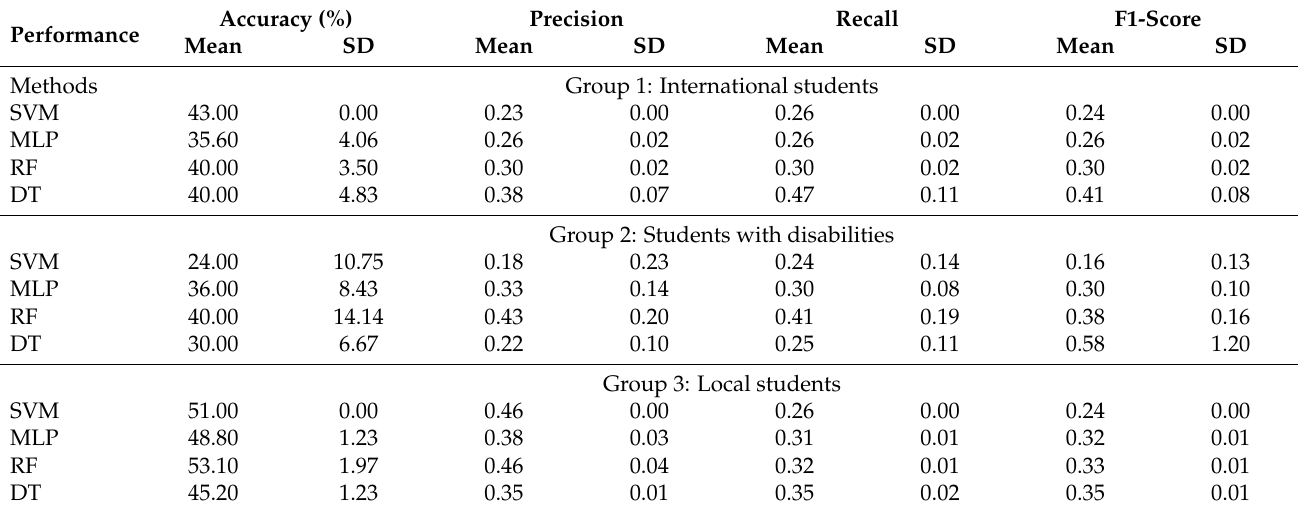
Table 2. Classification results of Case 1 (Origin).